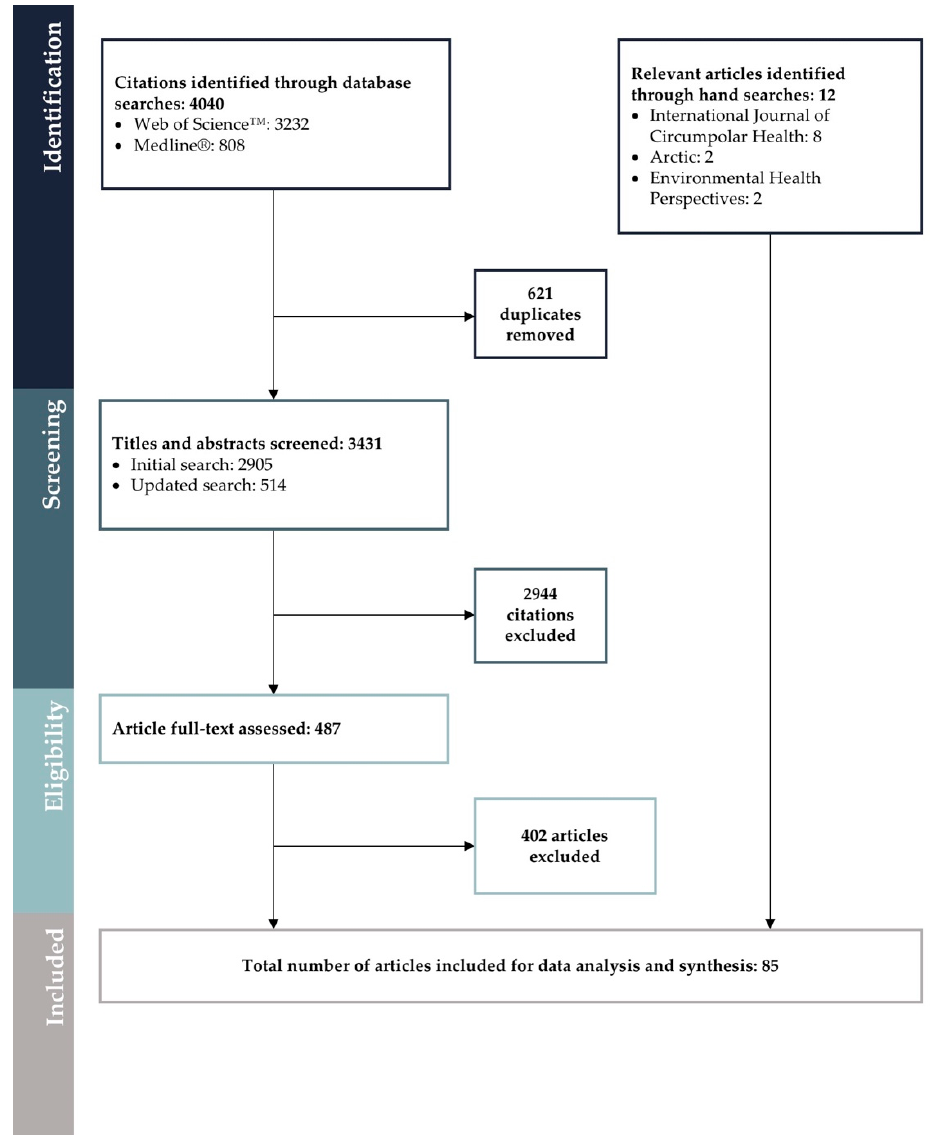
Figure 1. Diagram depicting the flow of identification, screening, and eligibility assessment of articles included in this review ( n = 85). Rationale for exclusion of full-text articles is provided in Appendix D.